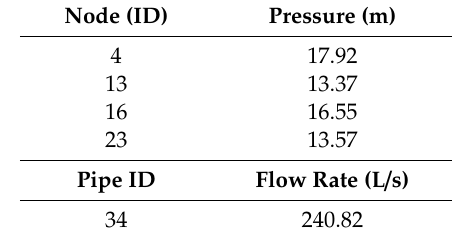
Table 1. Measured flow rate (on the bottom) and measured pressure (on the top) data for the Apulian network.